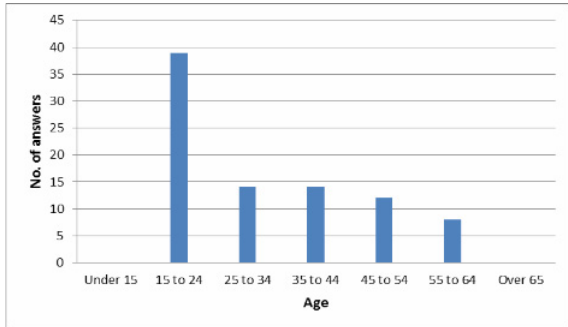
Figure 3. Age distribution of the sample